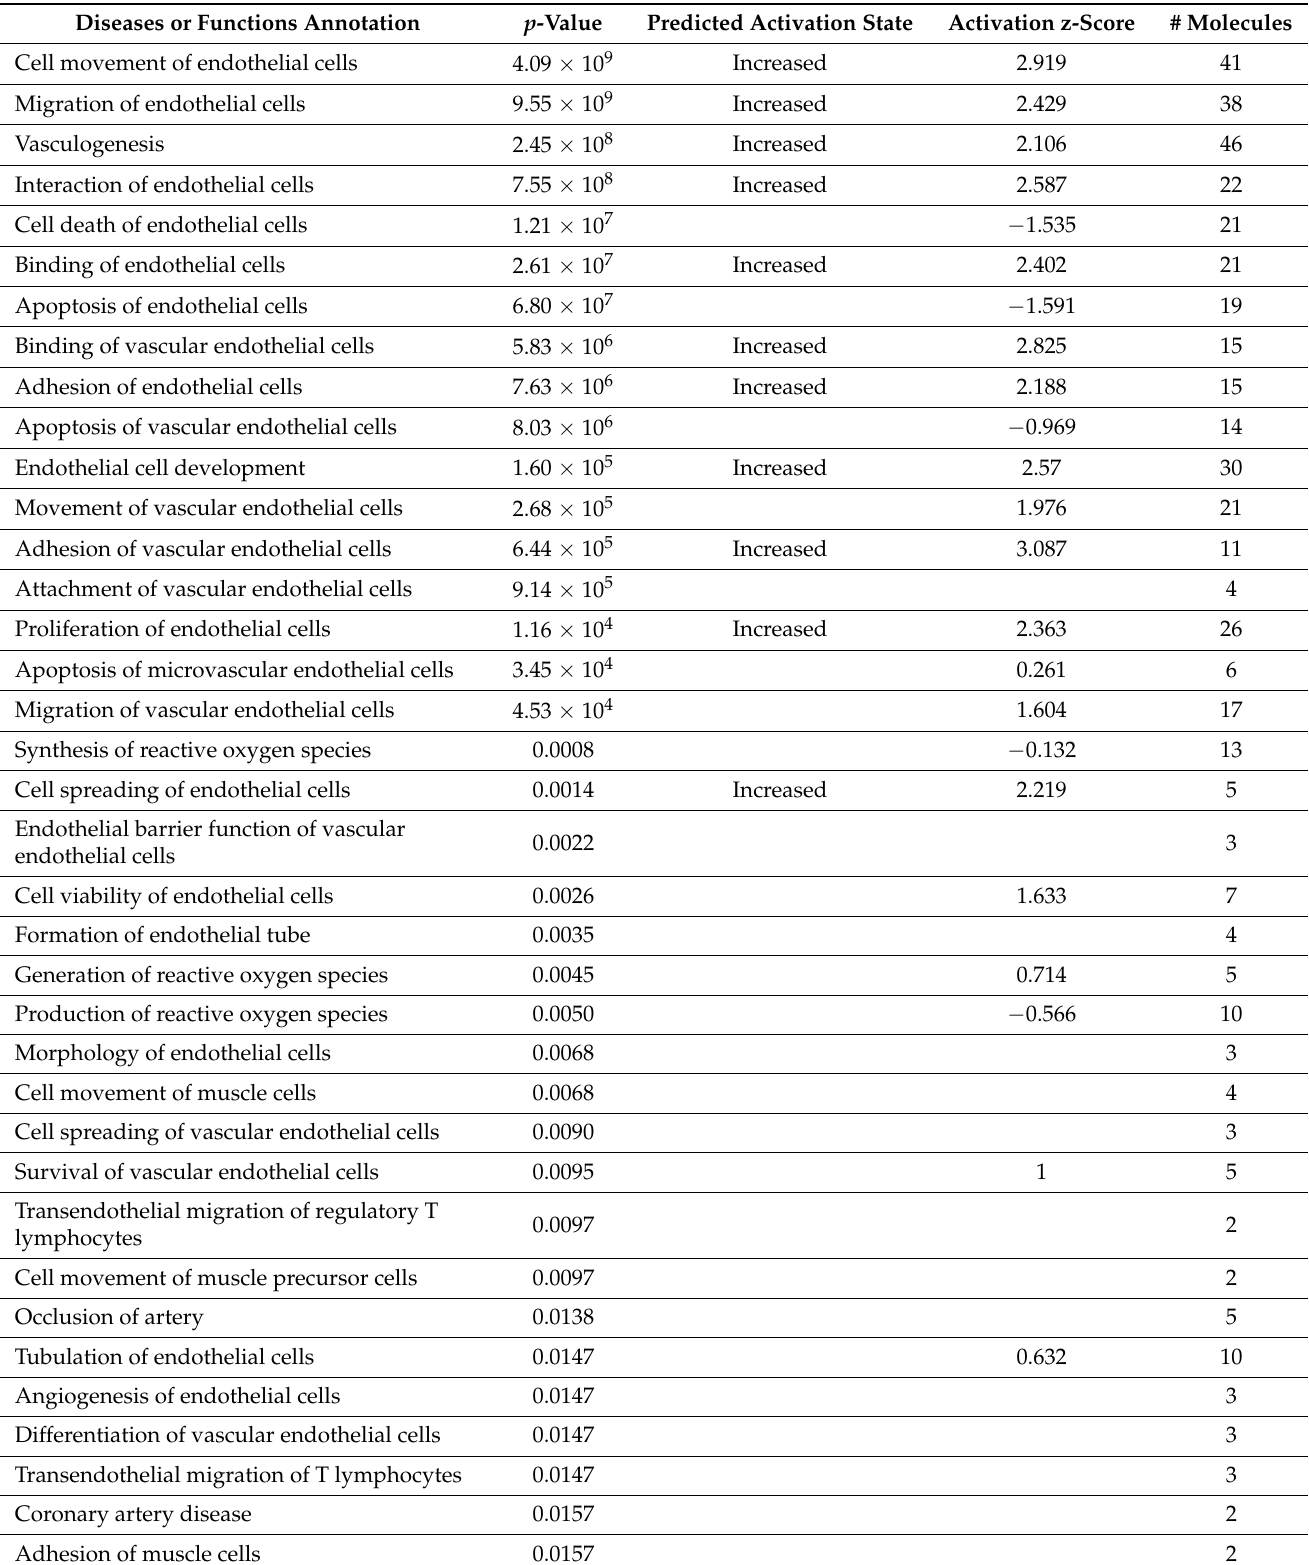
Table 2. Diseases and function annotation, performed by IPA analysis, obtained comparing eEV-IL-3 vs. eEV protein cargo. Diseases or Functions